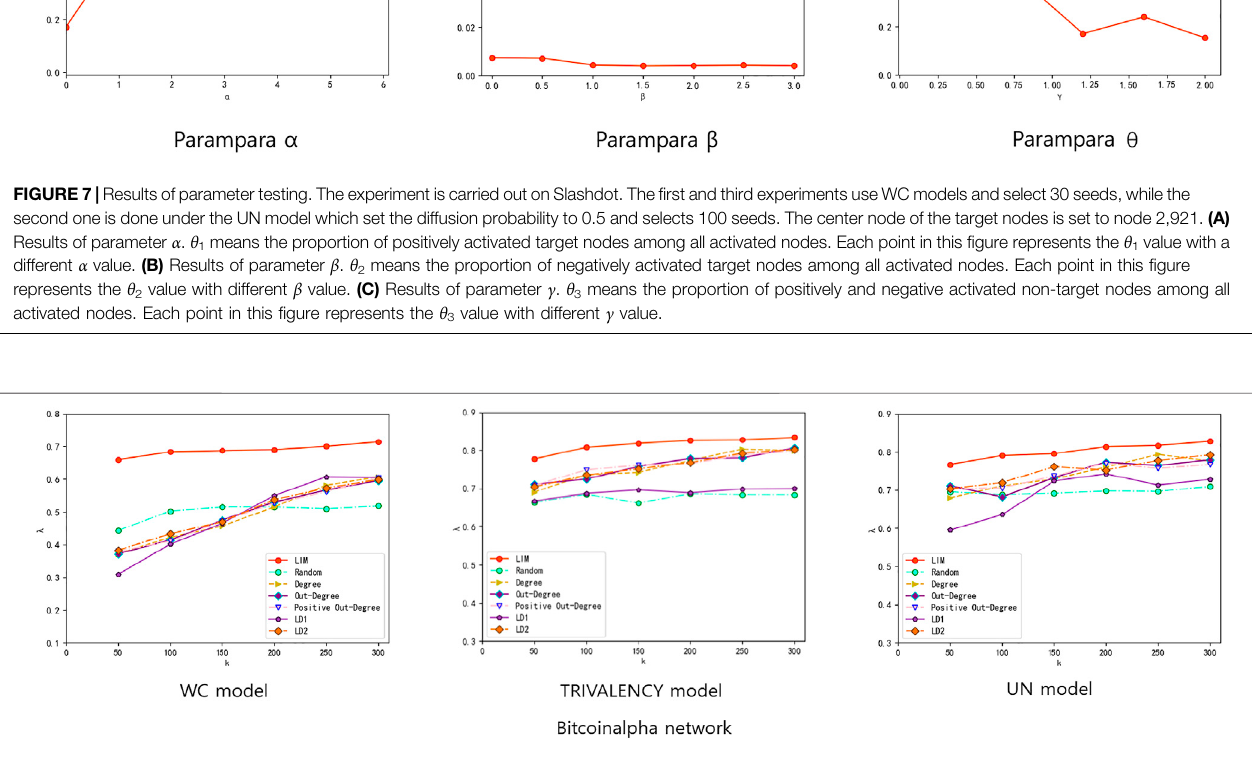
Frontiers in Physics |